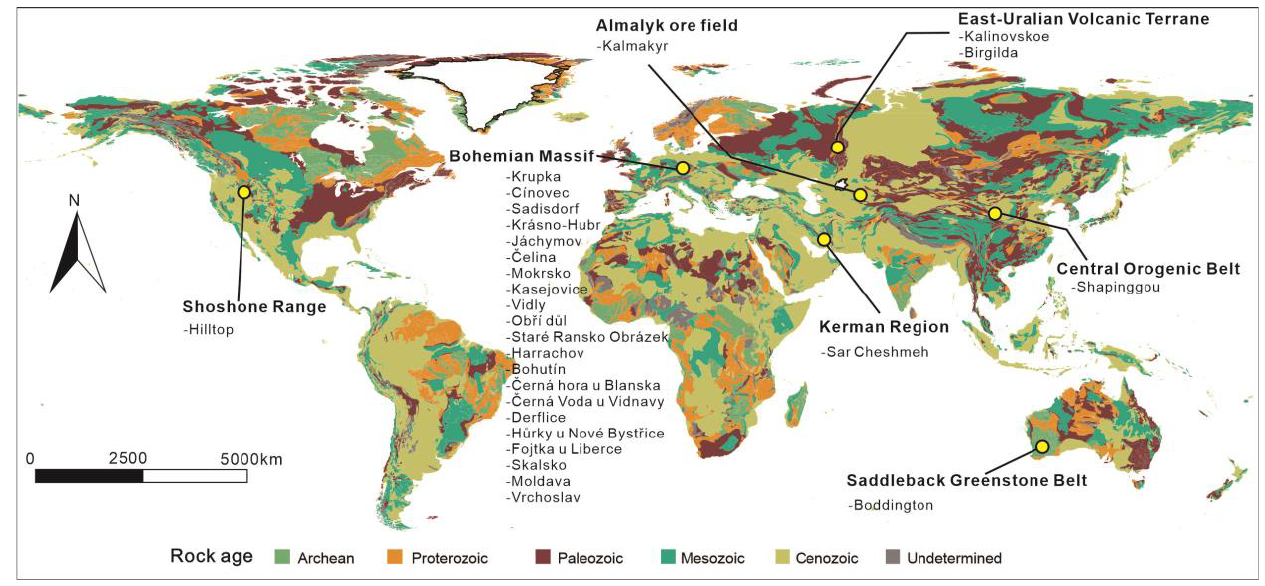
Figure 1. Distribution of the molybdenite samples from different deposits. The physical map of the world is from M. Colpron (Geological Survey of Canada, Ottawa, ON, Canada).